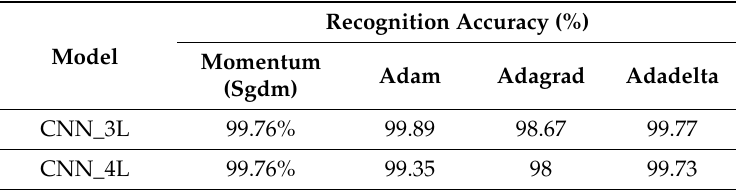
Table 4. Recognition accuracy with di ff erent optimizers.